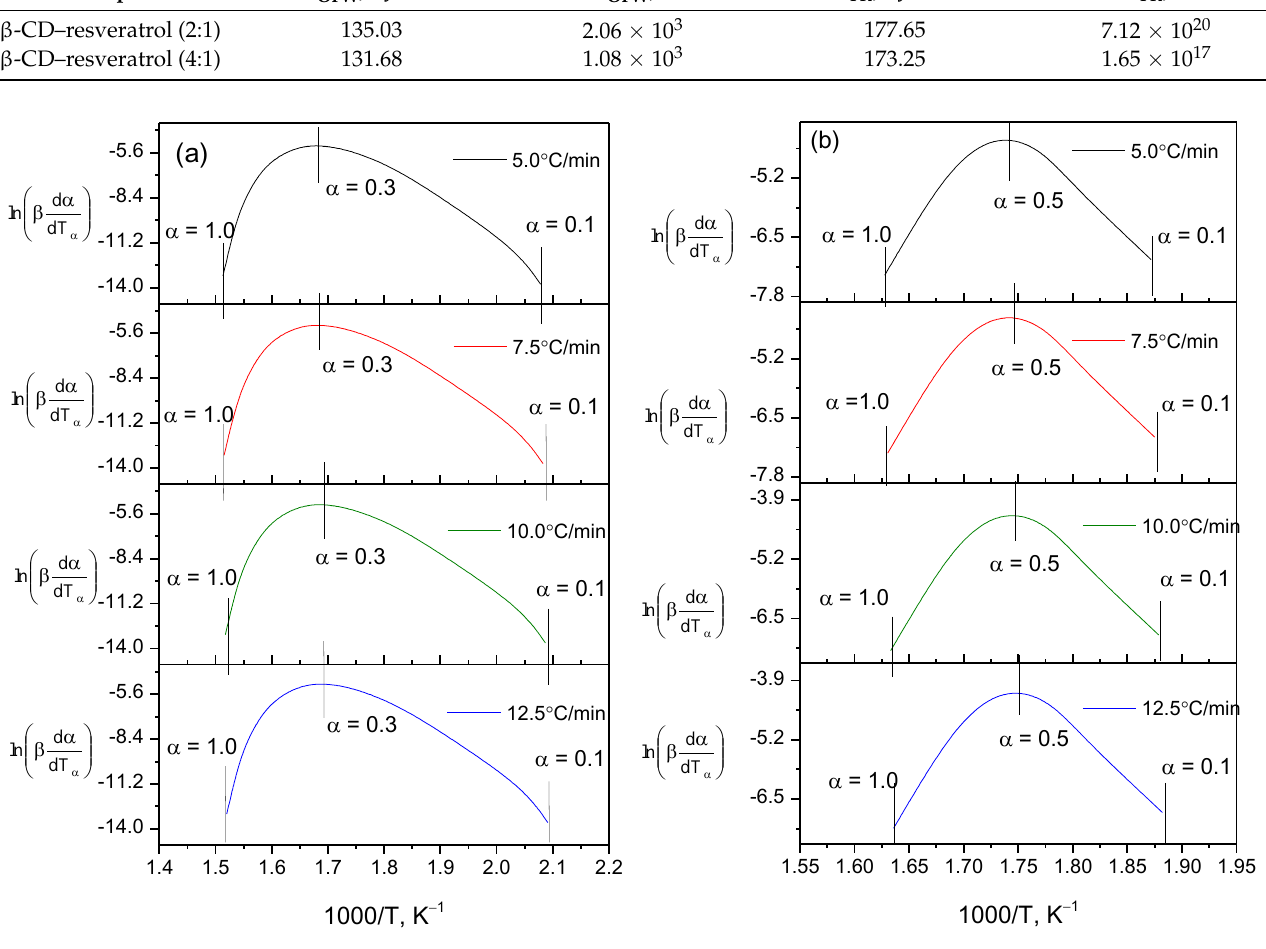
Figure 10. Logarithmic dependence ln analysis: ( a ) β -CD–resveratrol (2:1) and ( b ) β -CD–resveratrol (4:1) (Friedman method) at heating rates from 5 to 12.5 °C/min.